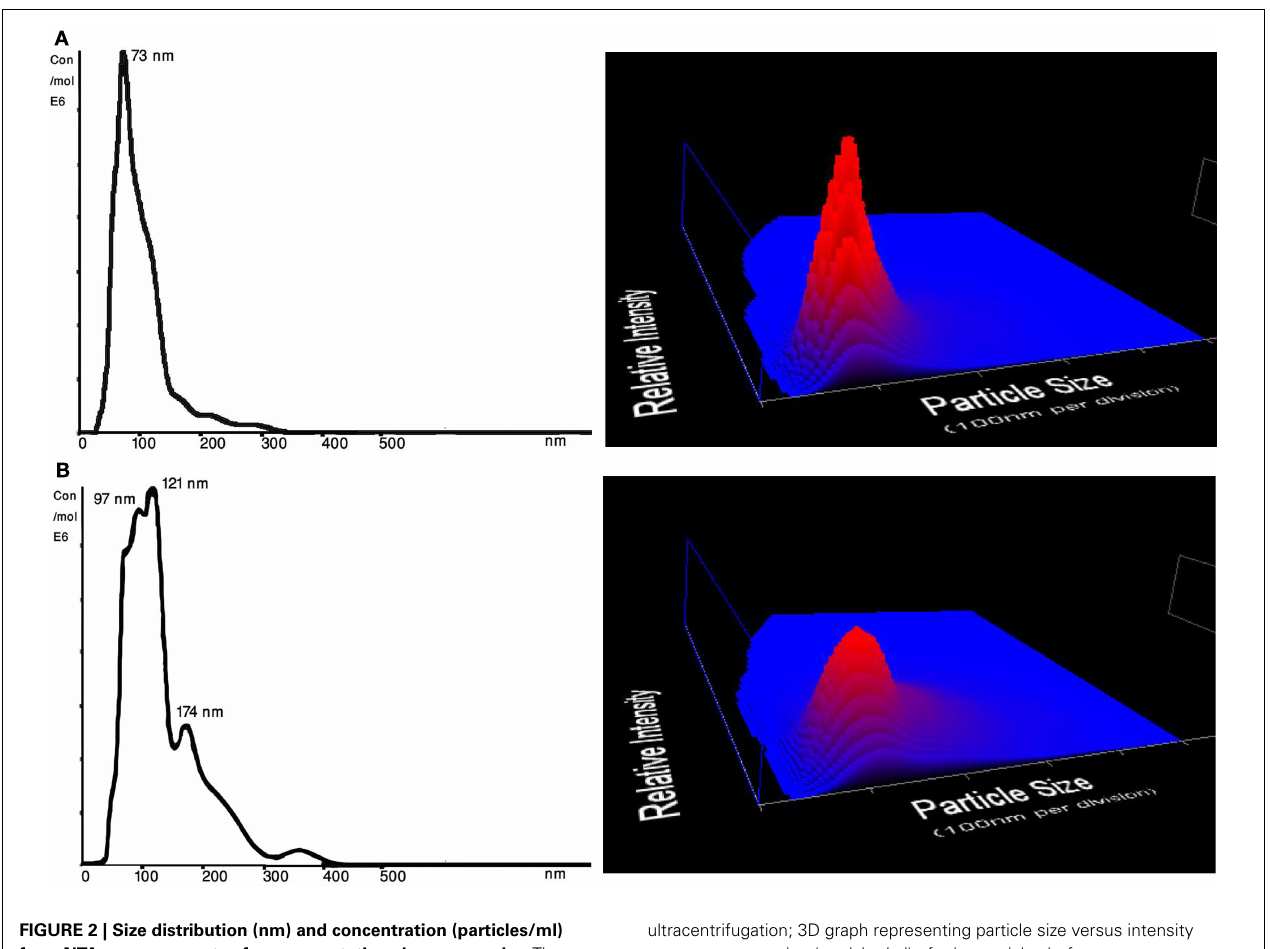
FIGURE 2 | Size distribution (nm) and concentration (particles/ml) from NTA measurements of a representative plasma samples. Three dimensional graph illustrating size versus intensity (relative frequency of each size range among the entire population of MVs) versus concentration (particles/ml) of microvesicles from plasma. (A) Plasma MVs Pre-UC – Average size of plasma MVs were 73nm before